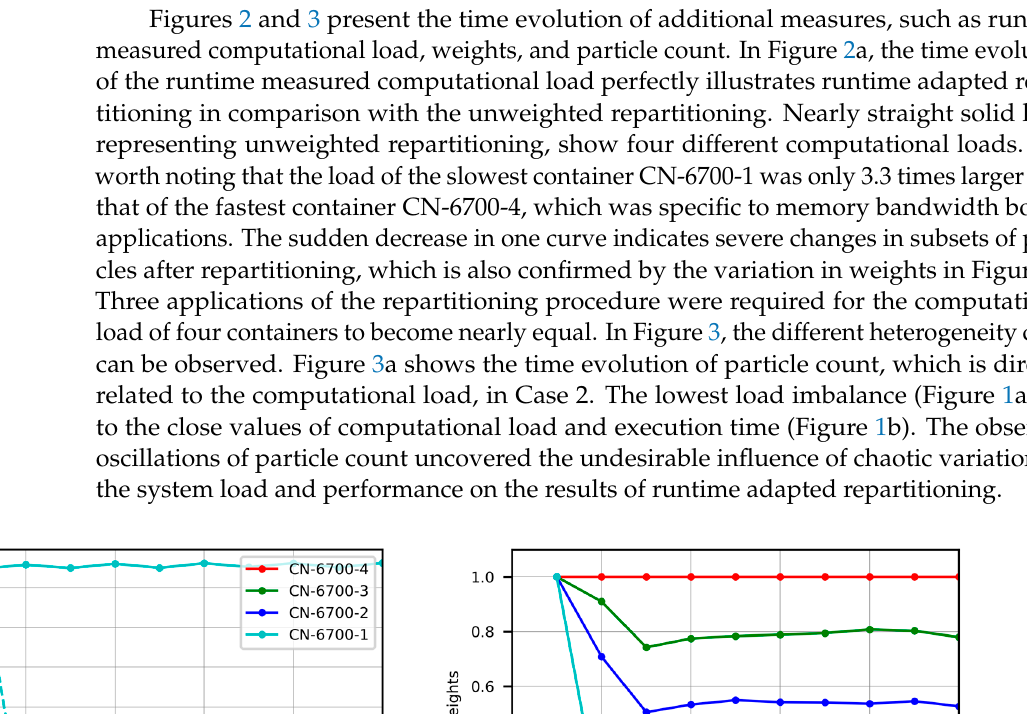
( b ) Figure 3. Time evolution of particle count in Case 2 ( a ) and computational load in Case 3 ( b ). Figure 3b shows the time evolution of the runtime measured computational load in Case 3. Initially, the load of any CN-6700-4 container is approximately 4 times larger than that of the powerful container CN-GPU. The difference in computational loads in Case 1 is lower than that in Case 3 despite the higher load imbalance of Case 1. This can be explained by the fact that the percentage load imbalance Formula (1) compares the maximal load with the averaged load. In Case 3, the load of any slower container serves as the maximal load, while the averaged load is highly influenced by five slower CN-6700- 4 containers and reduced by only one powerful container CN-GPU. Anyway, all curves of the computational load approached the average, which was closer to the initial load of